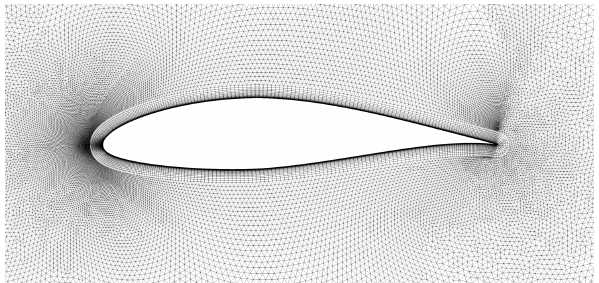
Figure 2. Fine grid (NACA 64 3 -618